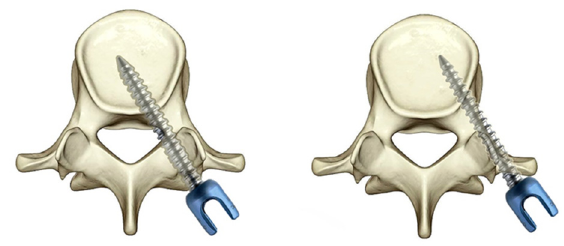
Figure 1. Diagram of type A and B screw according to RAO grading.